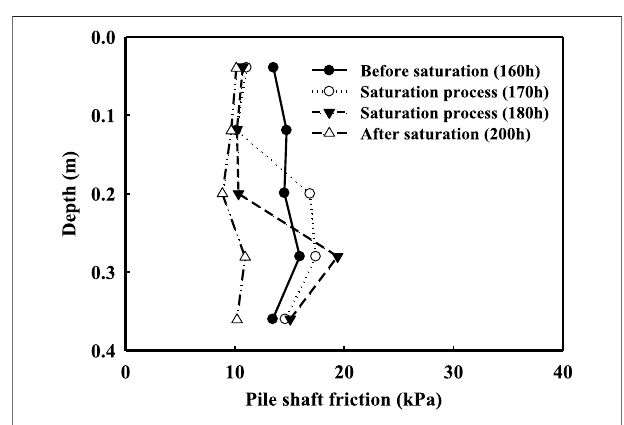
FIGURE 9 | Variations of pile shaft friction distribution of PITE.